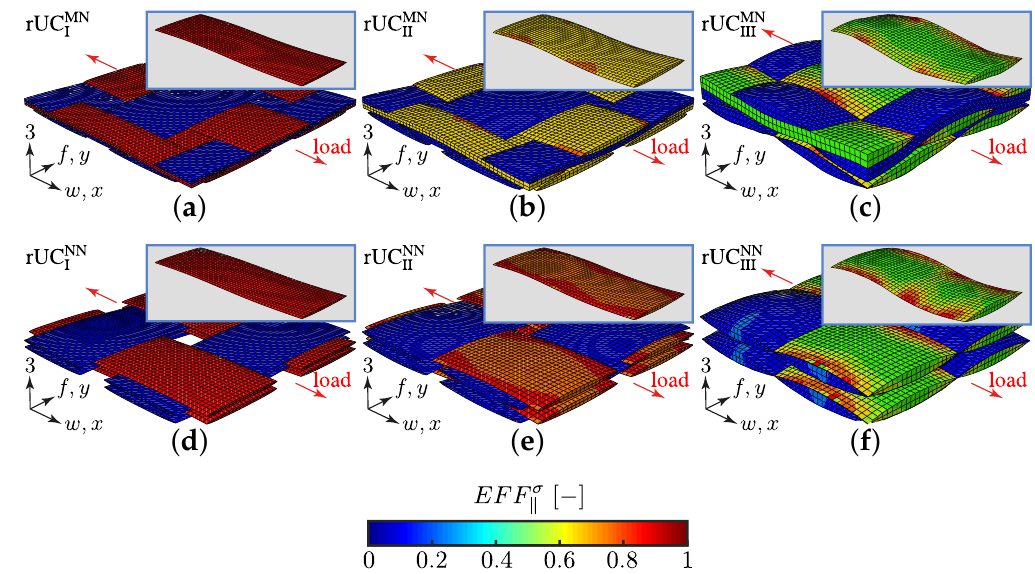
Figure 20. Exemplary illustration of the distribution of EFF σ considered rUC ( a ) rUC MN